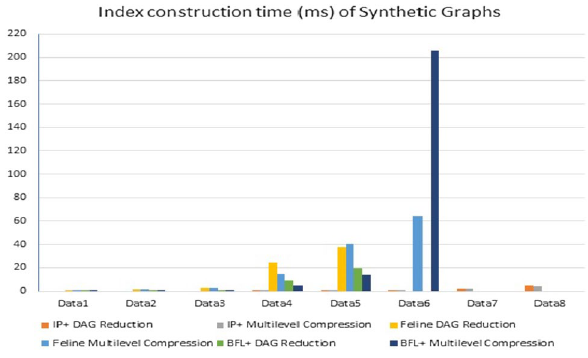
Fig. 7 Index construction time (ms) comparison for IP + , Feline and BFL